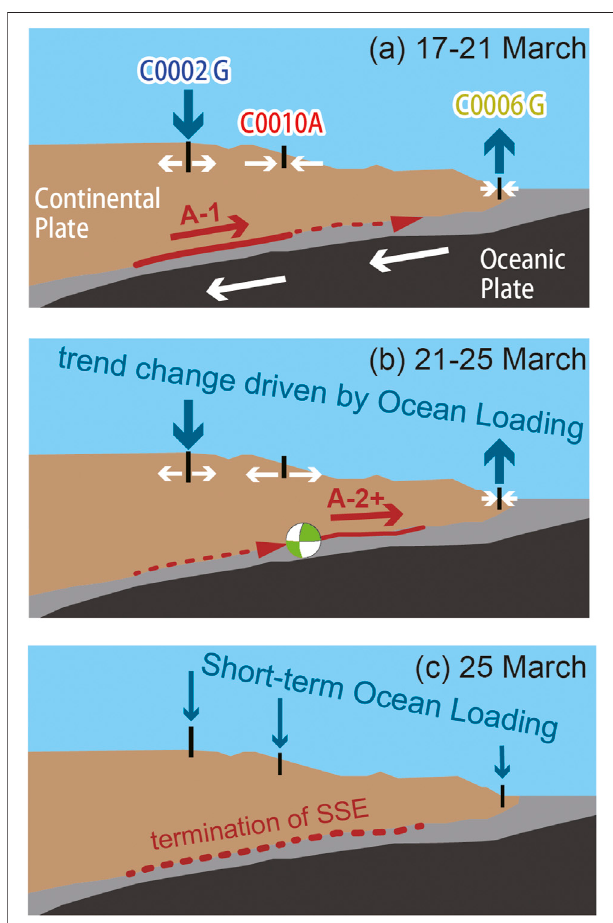
FIGURE 13 | Schematic scenario of the possible process for the SSE with ocean loading (A) during model A-1, (B) during model A-2+, and (C) termination of the SSE. Representative focal mechanism of VLFE is obtained from Ariyoshi et al. (2021). Double arrows represent volumetric strain change due to crustal deformation driven by the